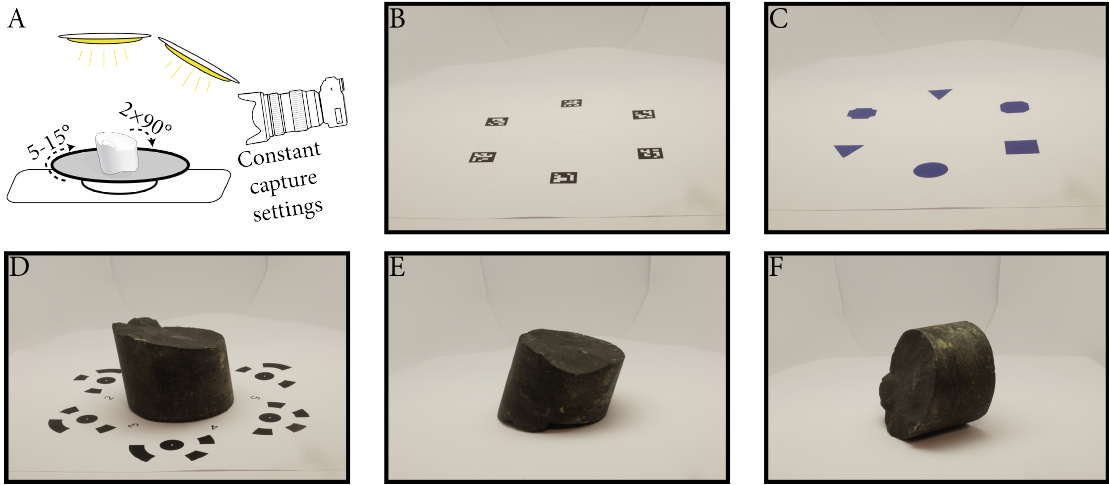
Figure 4. Overview of the digital image acquisition step. Using a well-lit turn table ( A ), the sample was captured from 5–15-degree angle intervals for each of the three orientations (top-down, ( D ); down-top, ( E ); and, sideways, ( F )). Markers ( B , D ) and (coordinate-less) calibration aids ( C ) were used for top-down and down-top